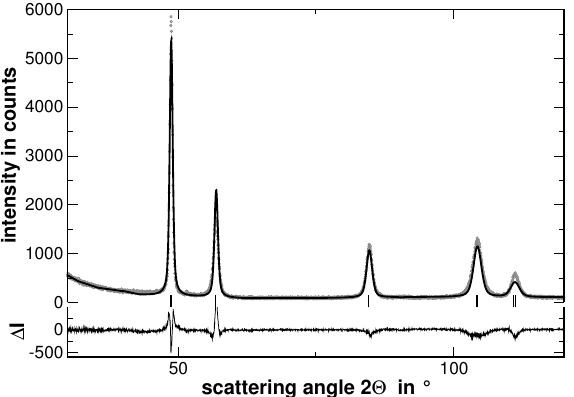
Figure A4. Experimental (points) and calculated (solid line) XRD patterns as well as their difference ∆ I (lower part) and Bragg positions (vertical lines) of homogenized